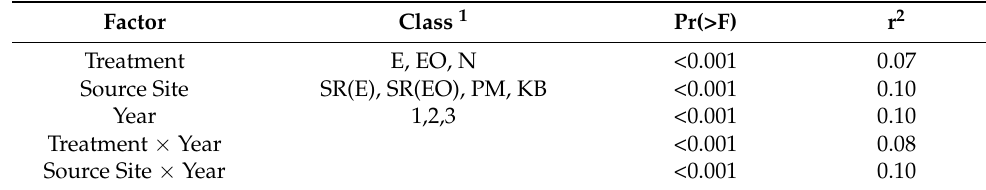
Table A5. perMANOVA based on Bray–Curtis dissimilarity metric on abundance of taxa collected during shoot sampling at San Rafael, Point Molate, and Keller Beach.